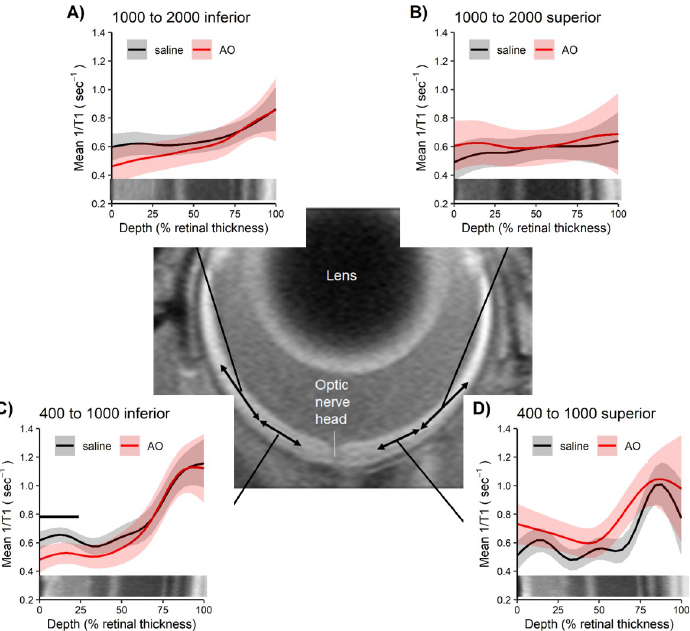
Fig 7. QUEST MRI in dark-adapted mice do not show outer oxidative stress. Modelled 1/T1 profiles approximately 1 hour post-sildenafil IP in dark-adapted mice given either saline (n = 6 mice, black line) or anti-oxidants (AO, n = 3 mice, red line) in these four retinal regions: A) 1000 to 2000 inferior, B) 1000 to 2000 superior, C) 400–1000 inferior, and D) 400–1000 superior; representative OCT images (bottom of each graph) provide spatial orientation. Only significant (horizontal black bar) AO reduction in 1/T1 indicative of oxidative stress are shown. Each profile has a solid line indicating the mean and a shaded region indicating 95% confidence intervals.